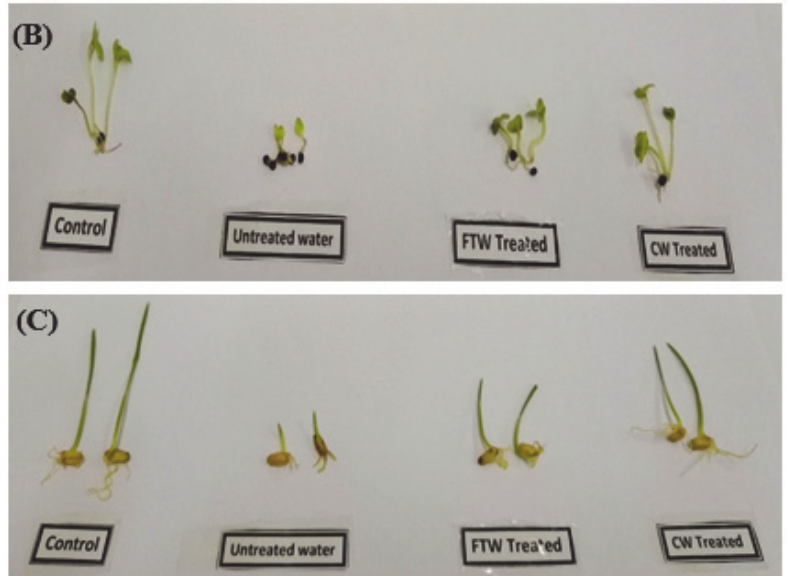
Figure 9. Bioassay to compare the treated water of CWs and FTWs: ( A ) visual comparison of tur ‐ bidity level of contaminated water treated in CTWs and FTWs; ( B ) Brassica napus seed germination in treated water of CWs and FTWs; ( C ) Triticum aestivum seed germination in treated water of CWs and